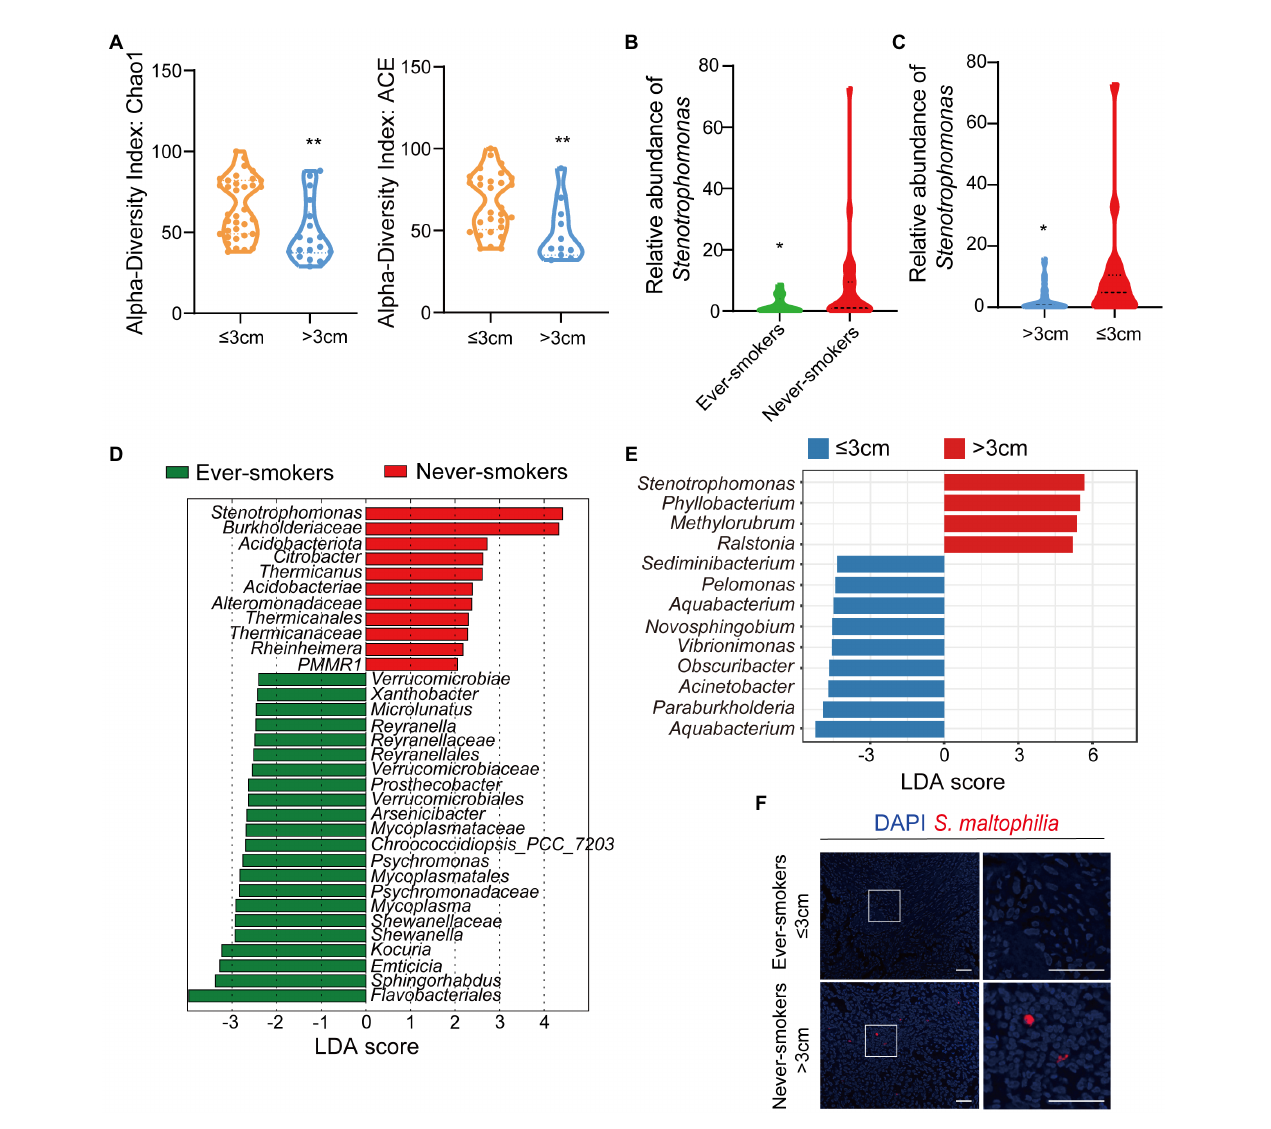
FIGURE 1 The microbiota was changed in lung tissues between the ever-smoker and never-smoker lung adenocarcinoma patients. (A) Taxonomic alpha-diversity calculated with the Chao index ( p = 0.0057) and Ace index ( p = 0.0058) between primary tumor size ≤ 3 cm and > 3 cm groups. (B) Relative abundances of Stenotrophomonas in the microbiota of ever-smoke and never-smoke groups. (C) Relative abundances of Stenotrophomonas in the microbiota of ≤ 3 cm and > 3 cm groups. (D) Linear discriminant analysis. Differential abundance of taxa was ranked according to their effect size between the Ever-smokers and Never-smoker groups. (E) Linear discriminant analysis. Differential abundance of taxa was ranked according to their effect size between primary tumor size ≤ 3 cm and > 3 cm group. The selection of discriminative taxa between groups was based on an LDA score cutoff of 3.0 and differences in the relative abundances of taxa (converted to log base 10) were statistically determined based on a Kruskal-Wallis and pairwise Wilcoxon tests. A value of p < 0.05 and a score ≥ 2.0 were considered significant. The length of the histogram represents the LDA score; i.e., the degree of influence of species with significant differences between different groups. (F) Representative FISH images of LADC tissue sections using a fluorescent probe specific to Stenotrophomonas . * p < 0.05, ** p < 0.01 by Student’s